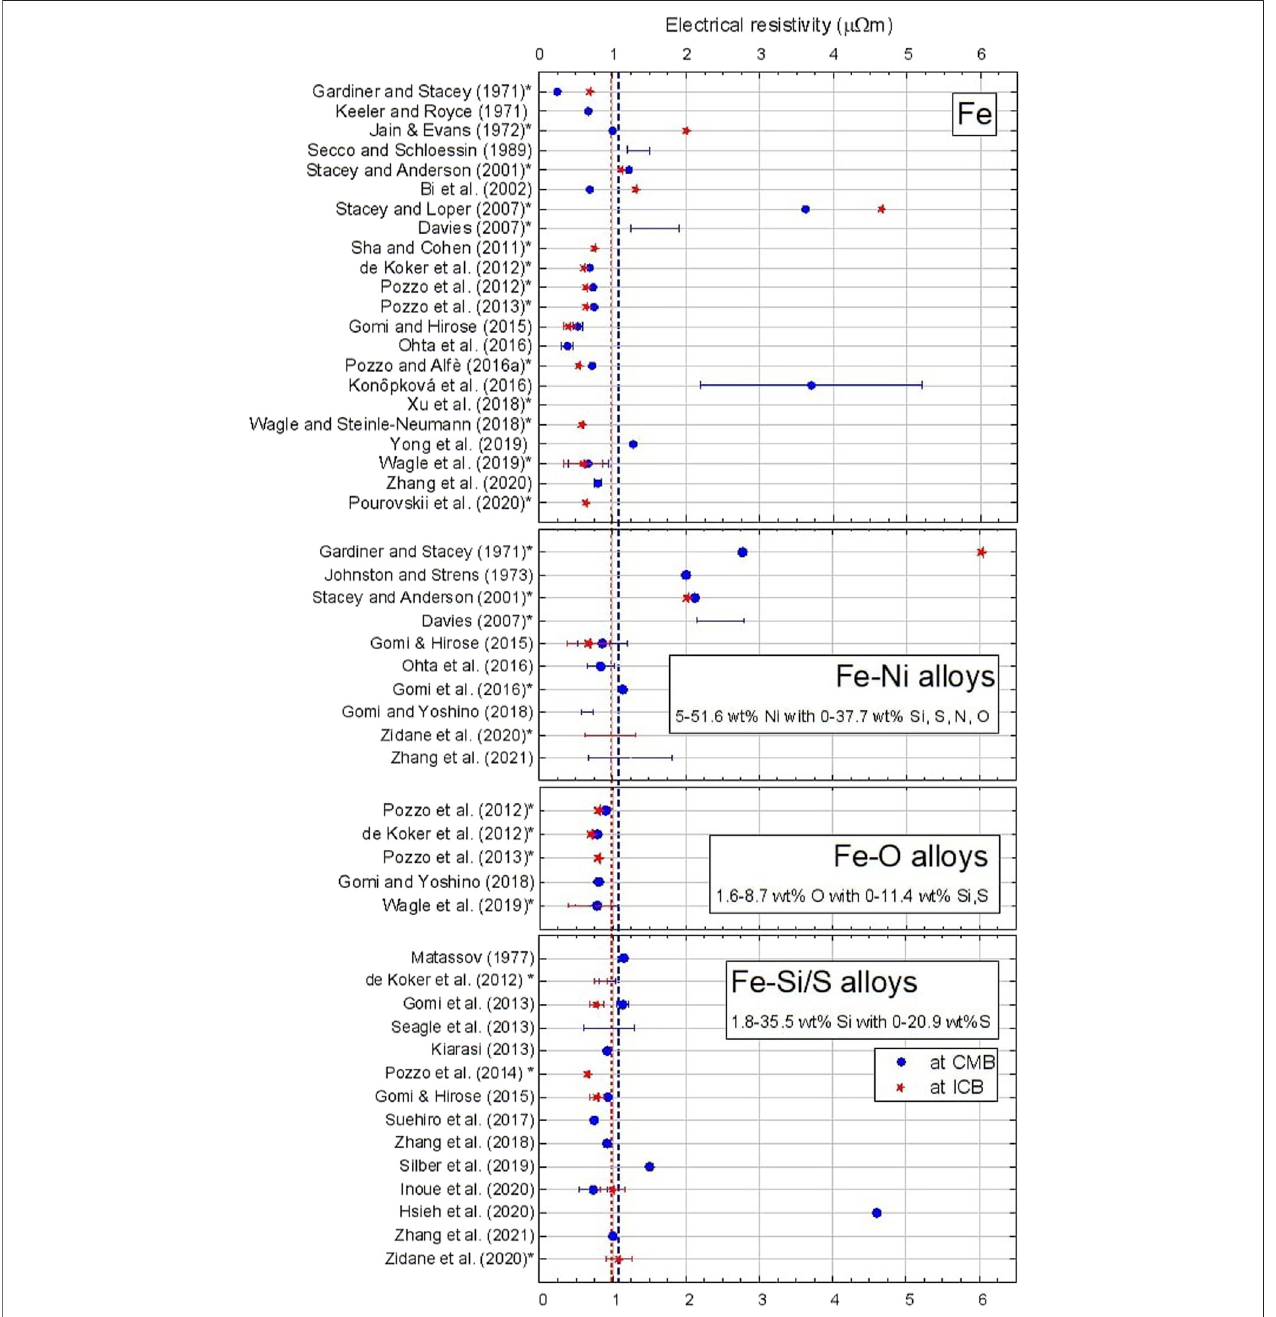
FIGURE 2 | Combined values of ρ from the literature applied to Earth ’ s core presented in date order. The blue dashed line represents the average values (without values > 3 µ Ω m) at the CMB, while the red dashed line represents the average values at the ICB. The average of all reported values at CMB (4,000 K, 136 GPa) conditions is 1.07 µ Ω m, and that at ICB (5,000 K, 330 GPa) is 0.97 µ Ω m. The * denotes theoretical studies. Repeated references indicate different compositions.